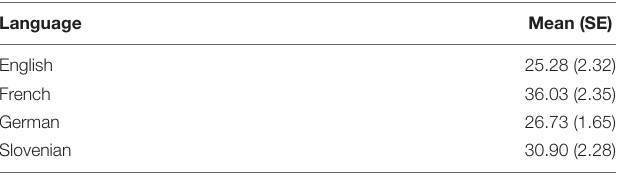
TABLE 2 | Experiment 1: Mean times (standard error) spent by the participants on a single screen, broken down by language.